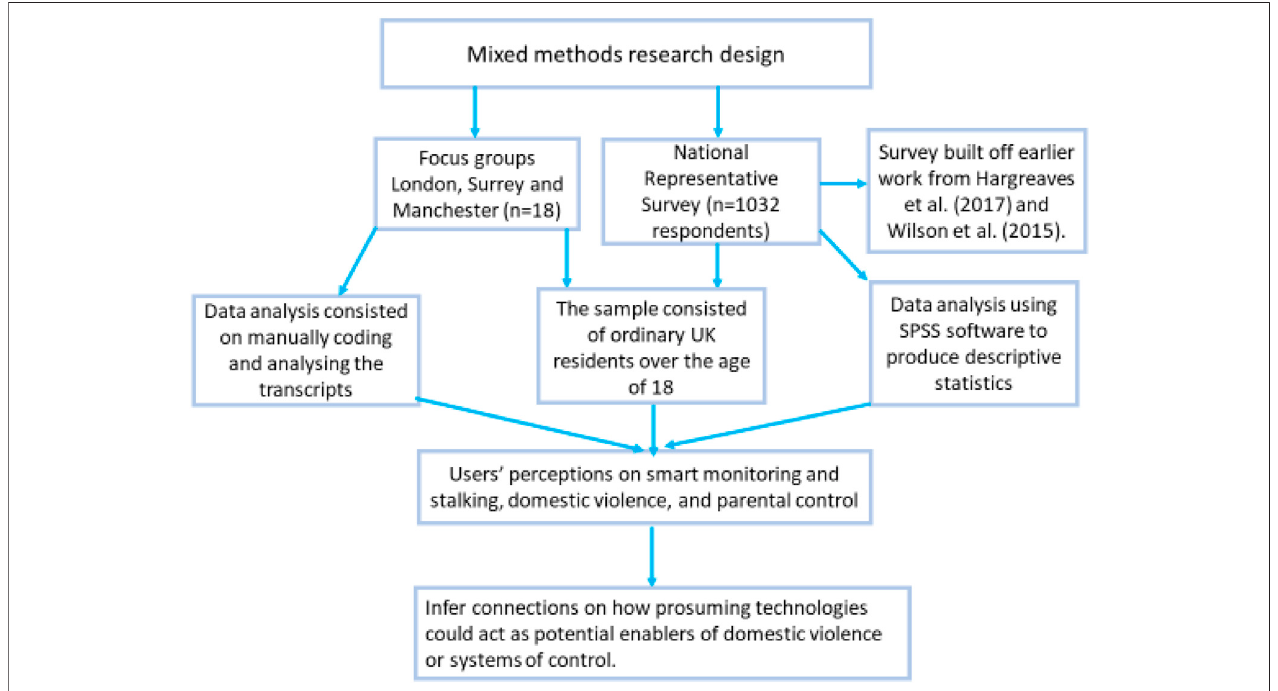
FIGURE 1 | Visualizing our research design and dataset fl